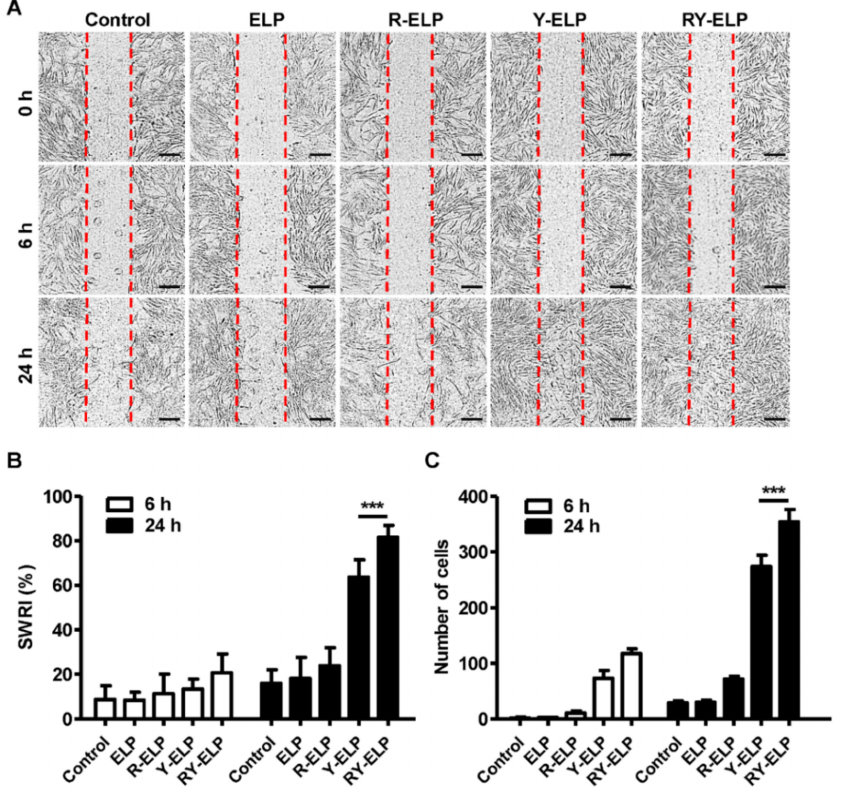
Figure 6. Migration assay. ( A ) Representative phase-contrast images of wounded MSCs cultured on a fusion-ELP-coated surface as compared with uncoated over a 24-h period ( n = 3), Scale bars: 100 µ m. ( B ) The bar graph represents the percentage of scratch wound recovery index (SWRI) at different time points. *** p < 0.001 significance difference of Y-ELP or RY-ELP compared with untreated control ( n = 3). ( C ) Quantitative determination of total migratory MSCs at different time points ( n = 3), *** p < 0.001 significance of Y-ELP or RY-ELP compared with untreated